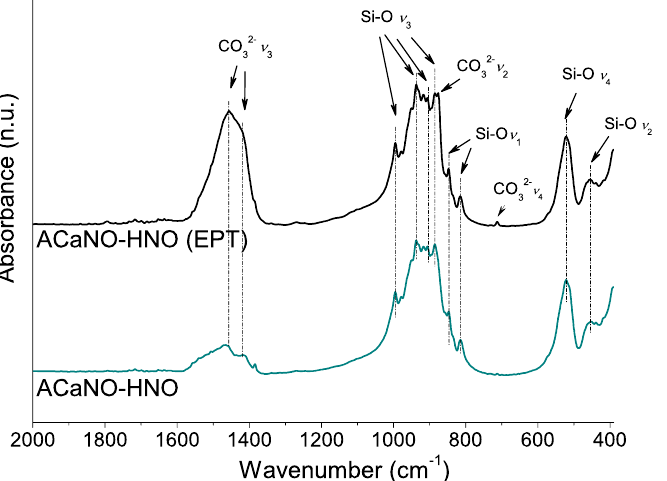
Figure 6. FT-IR analysis of unhydrated sol – gel BECs heat-treated at 1400 °C: without post-synthesis treatment (ACaNO-HNO), and after EPT (ACaNO-HNO (EPT)).